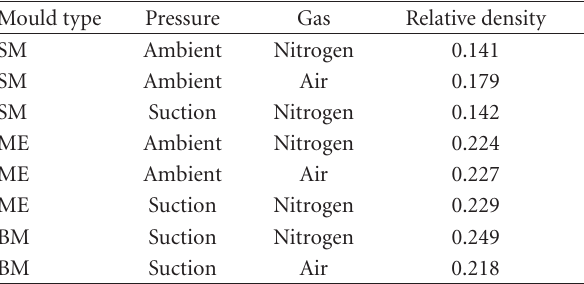
Table 3: Process parameters and relative density.